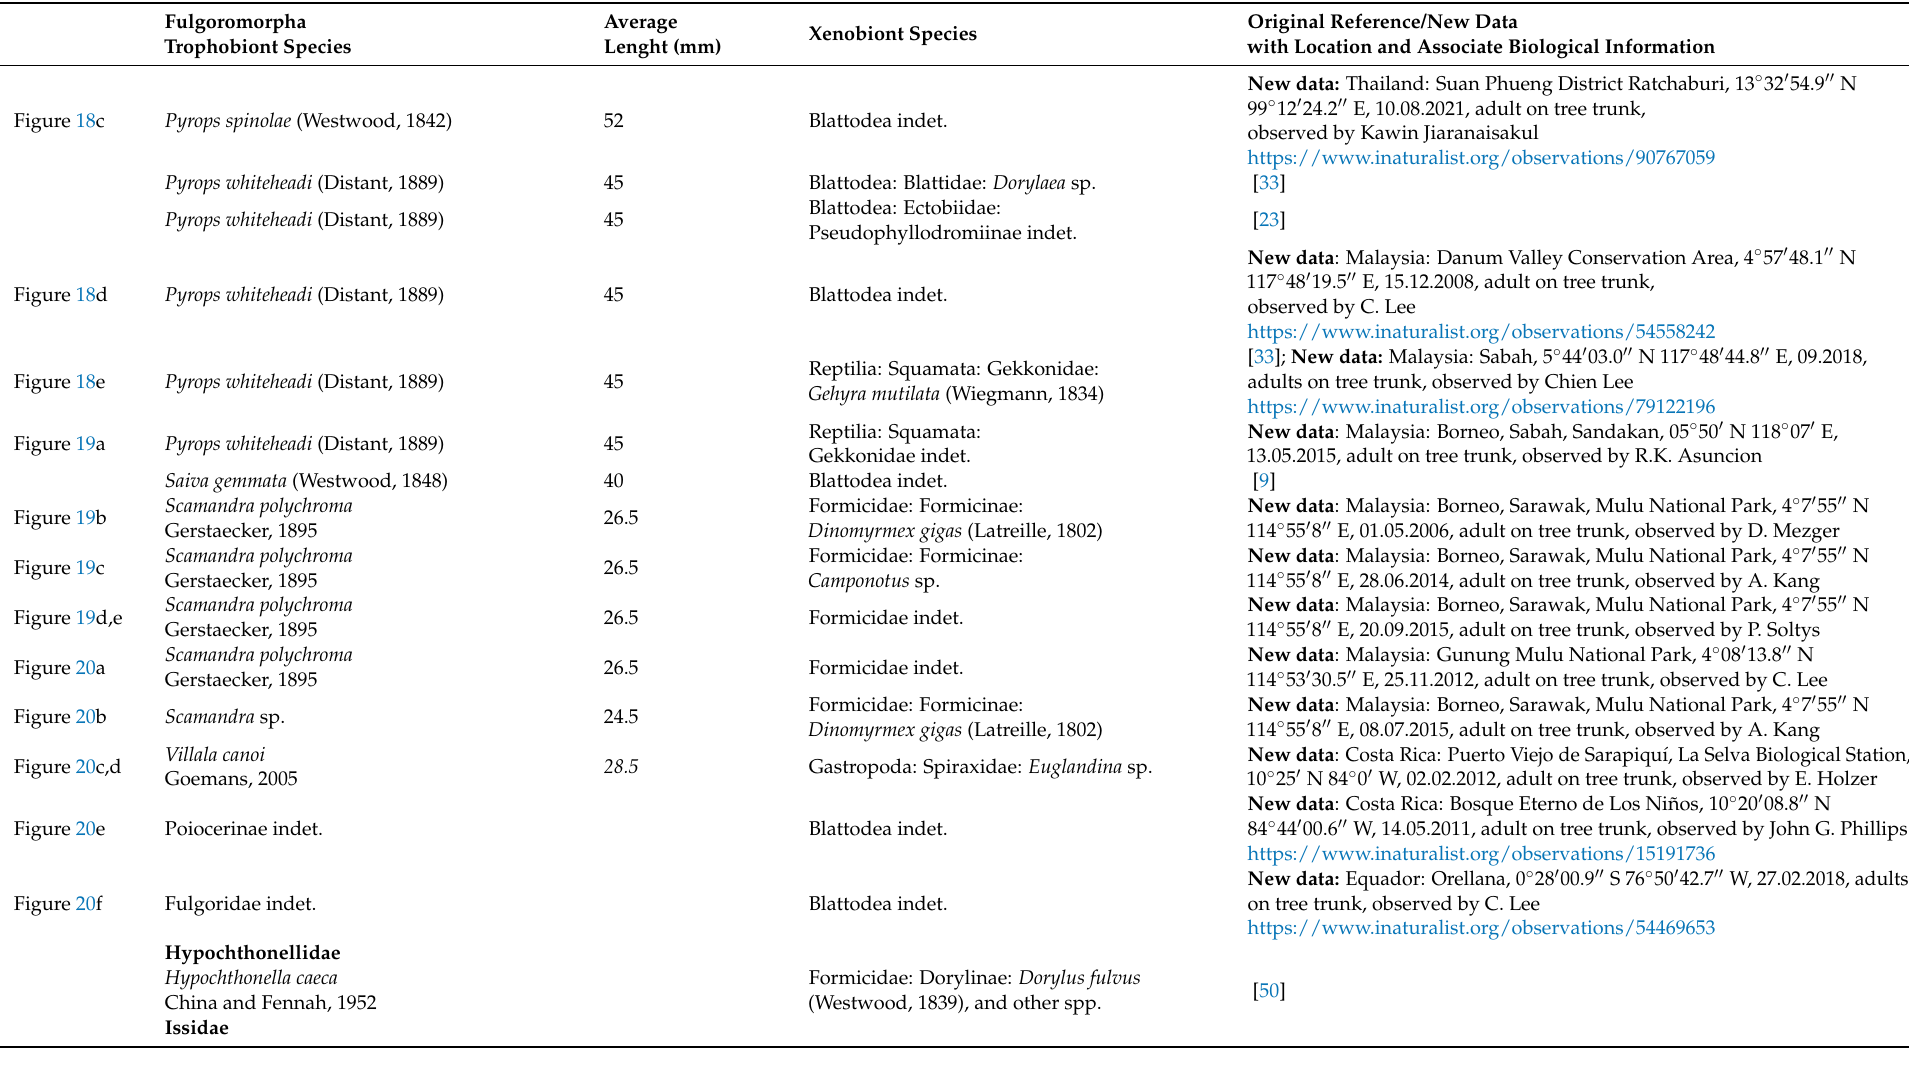
Figure 20f Fulgoridae indet. Blattodea indet. Hypochthonellidae Hypochthonella caeca China and Fennah, 1952